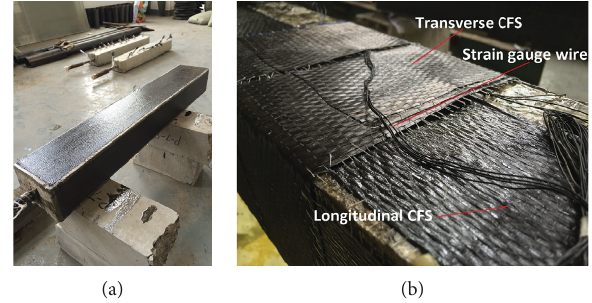
Figure 3: The manufacturing process of CFS.